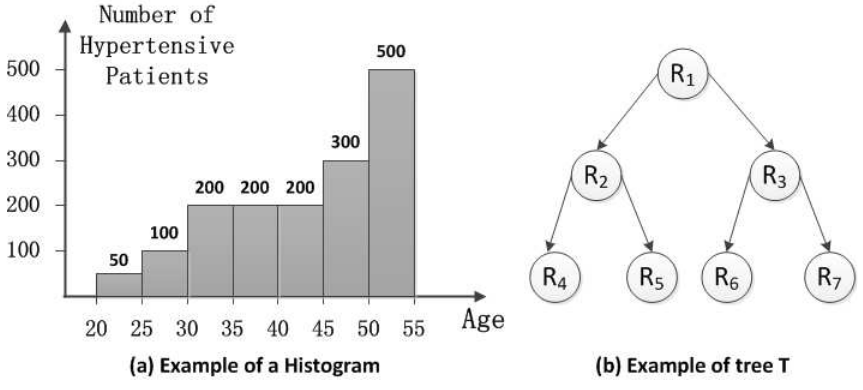
Figure 2. ( a ) Example of a histogram. ( b ) Example of query tree